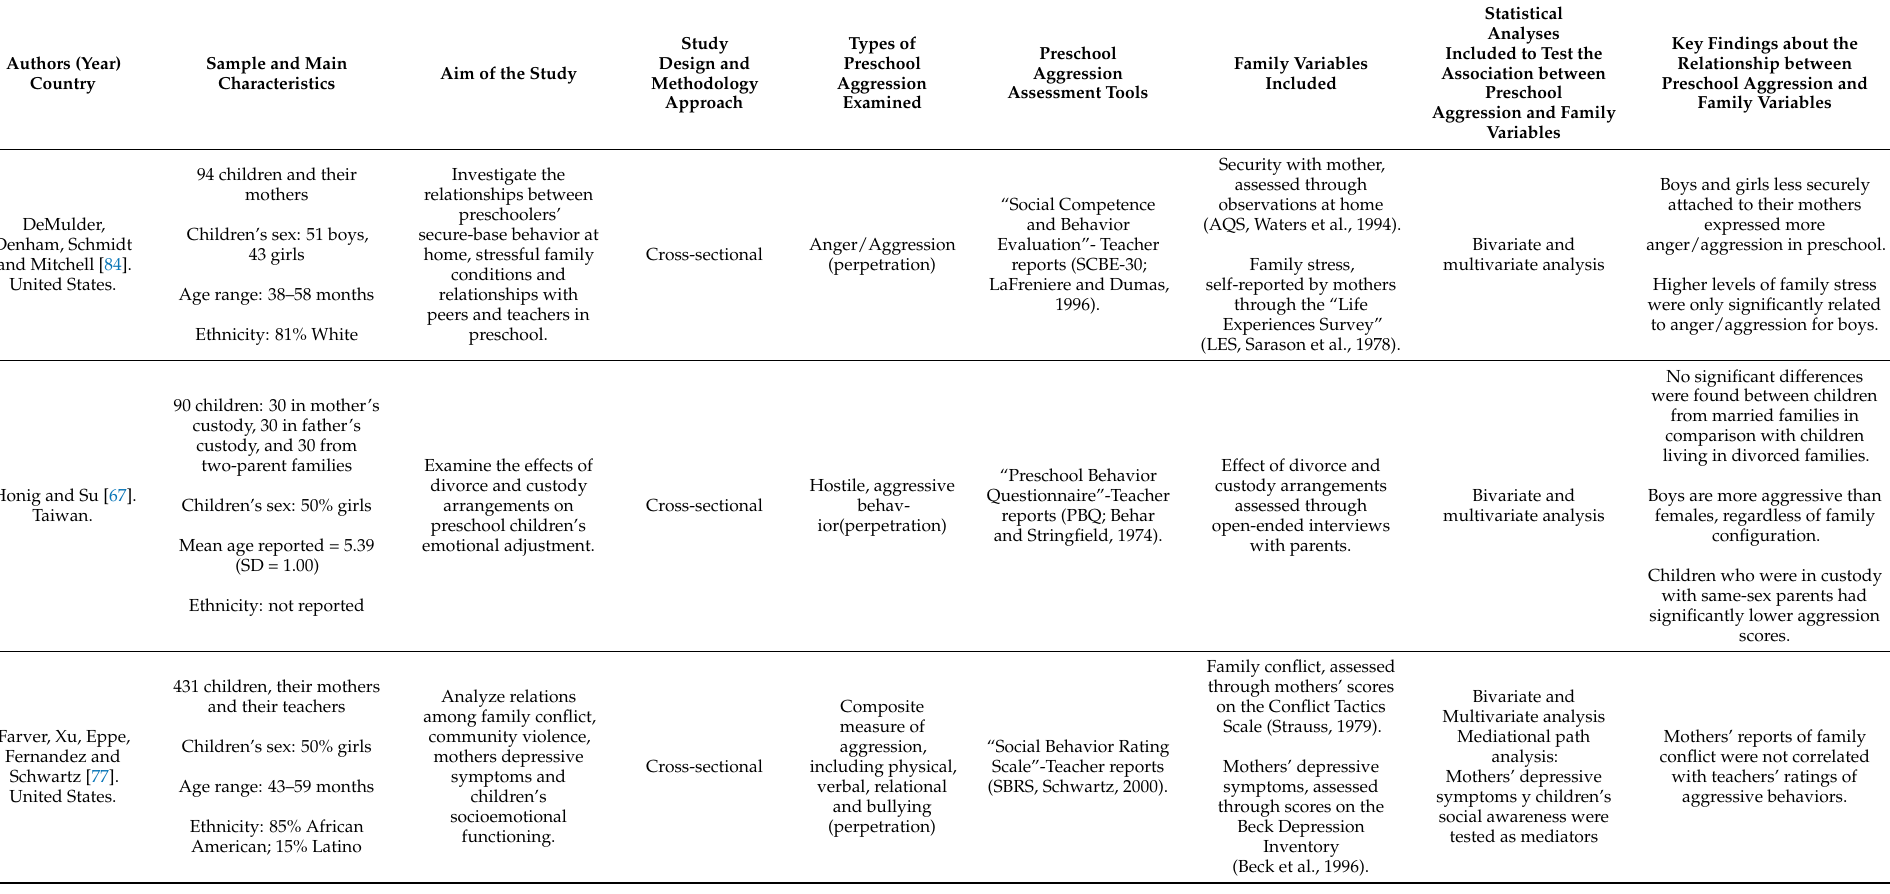
Table A1. Analysis of the selected studies ( n =